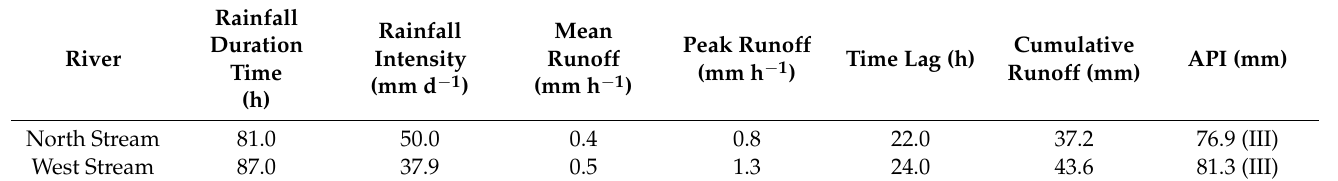
Table 1. The characteristics of the rainfall and runoff in the two tributaries during the rain